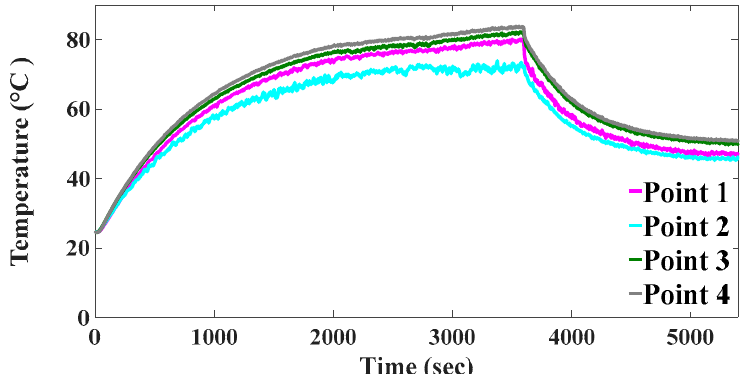
Figure 20. Temperature responses in Type I upper-plate point.